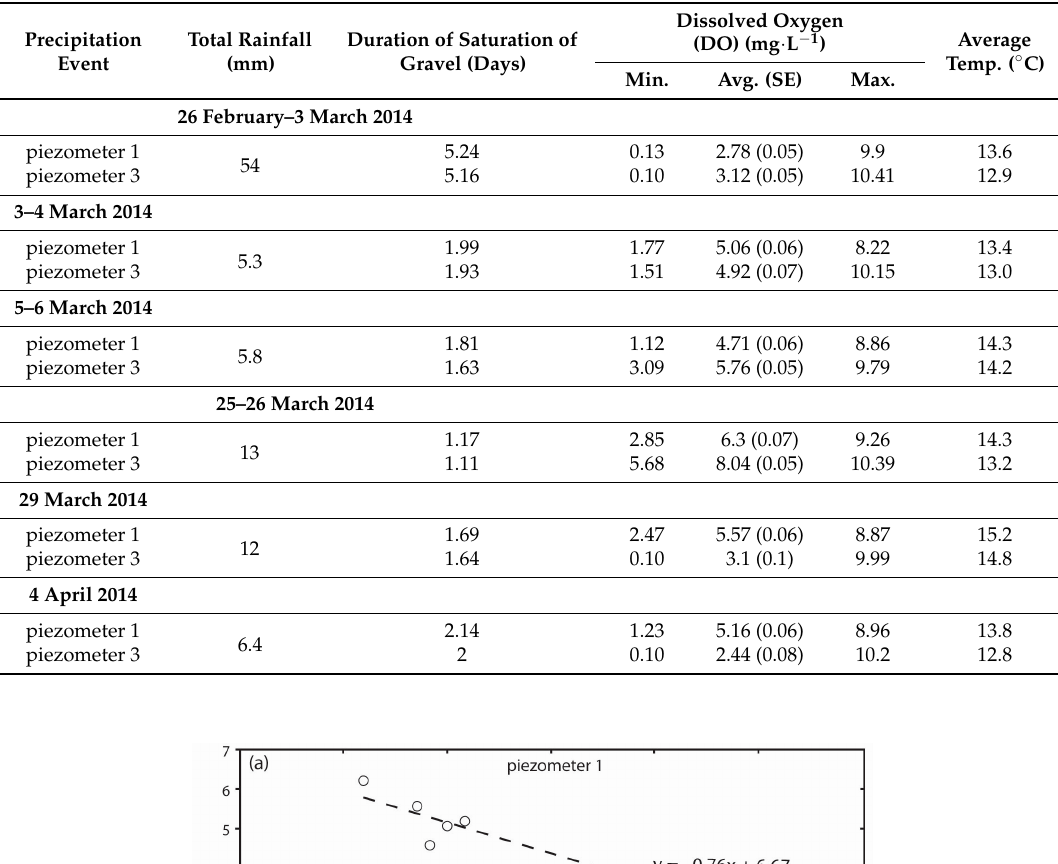
Table 1. Durations of saturation of gravel and dissolved oxygen (DO) concentrations for piezometers 1 and 3 during precipitation events February to April 2014. The standard error (SE) of the average is shown in parentheses. Note that MiniDOT reporting level for DI is 0.3 mg/L (10 µ mol/L).